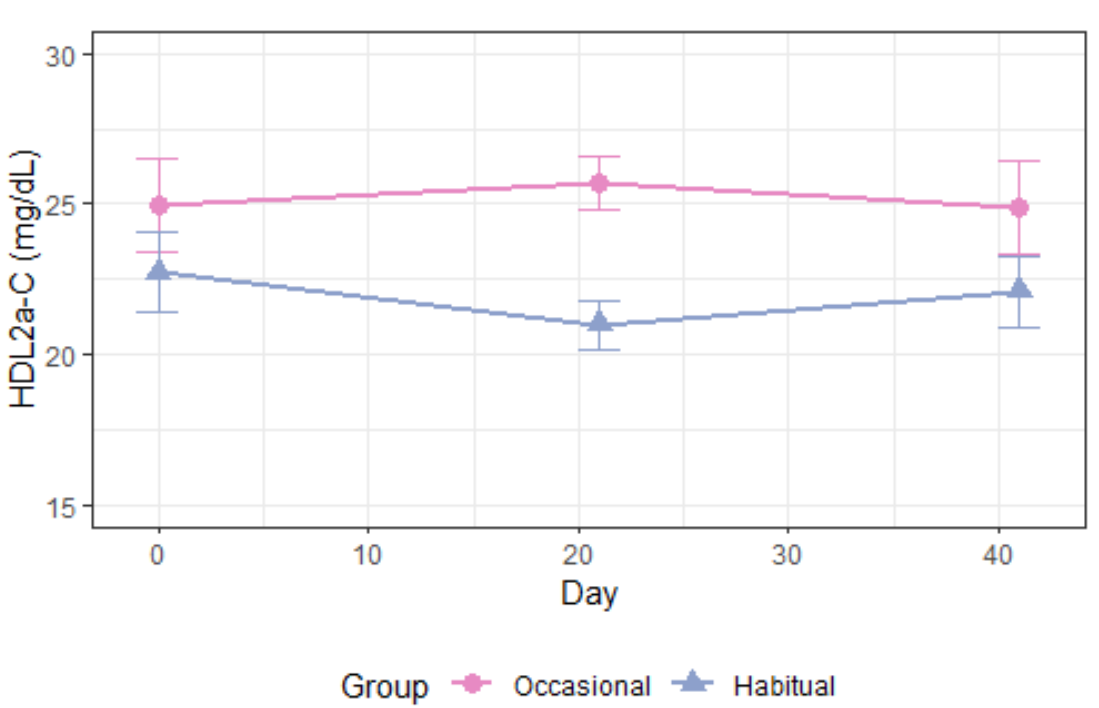
Figure 4. Circulating HDL 2a -C during 3 weeks in period 1 and 3 weeks in period 2. Occasional drink-